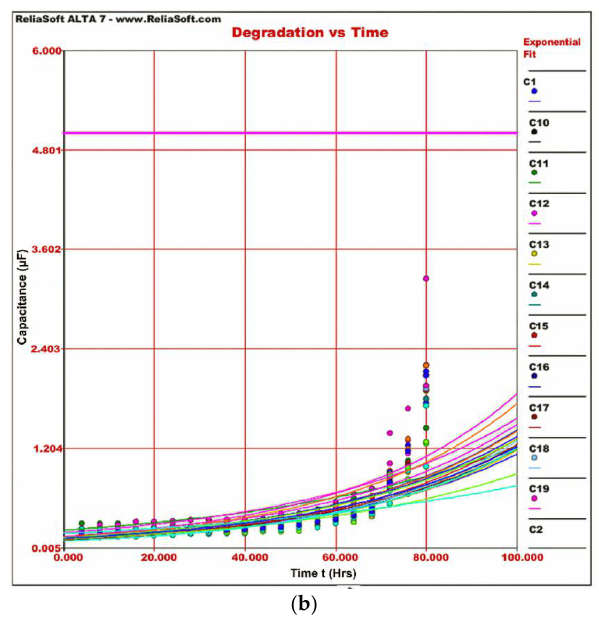
Figure 7. Capacitor degradation vs. time. ( a ) Leakage current vs. time; ( b ) capacitance vs. time. The second weaker link is the diode in the electronic fuze, again twenty diodes are subjected to accelerated life testing at higher degrees of temperature. This helps to obtain the degradation data and to study the effect of thermal stresses on different characteristics of diode and failure modes triggered by these thermal stresses. The component datasheet, storage, and operational conditions provide useful information about stress levels, and hence the calculation of the acceleration factor. relation. The values obtained for forward voltage ( V F ) and leakage current ( I r ) at high temperatures